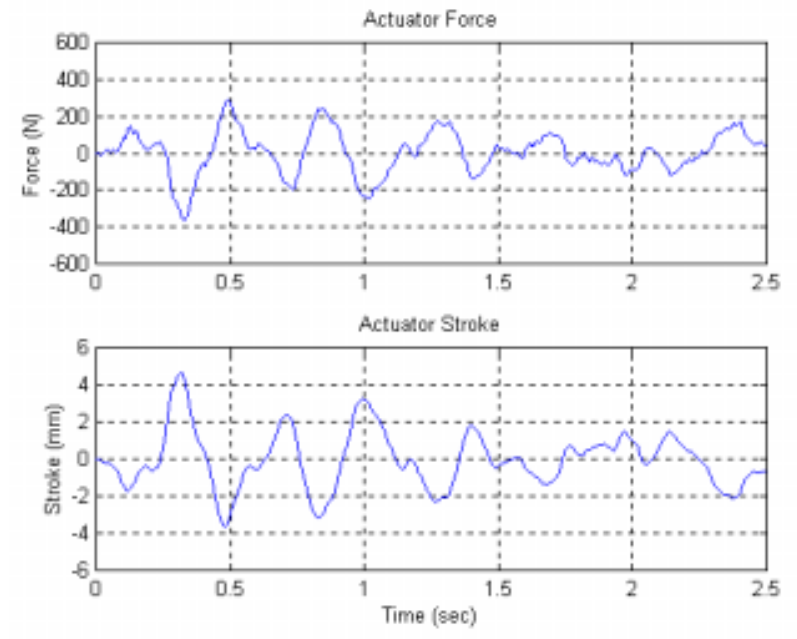
Fig. 6. Force and stroke levels computed from the car and seat simulations.